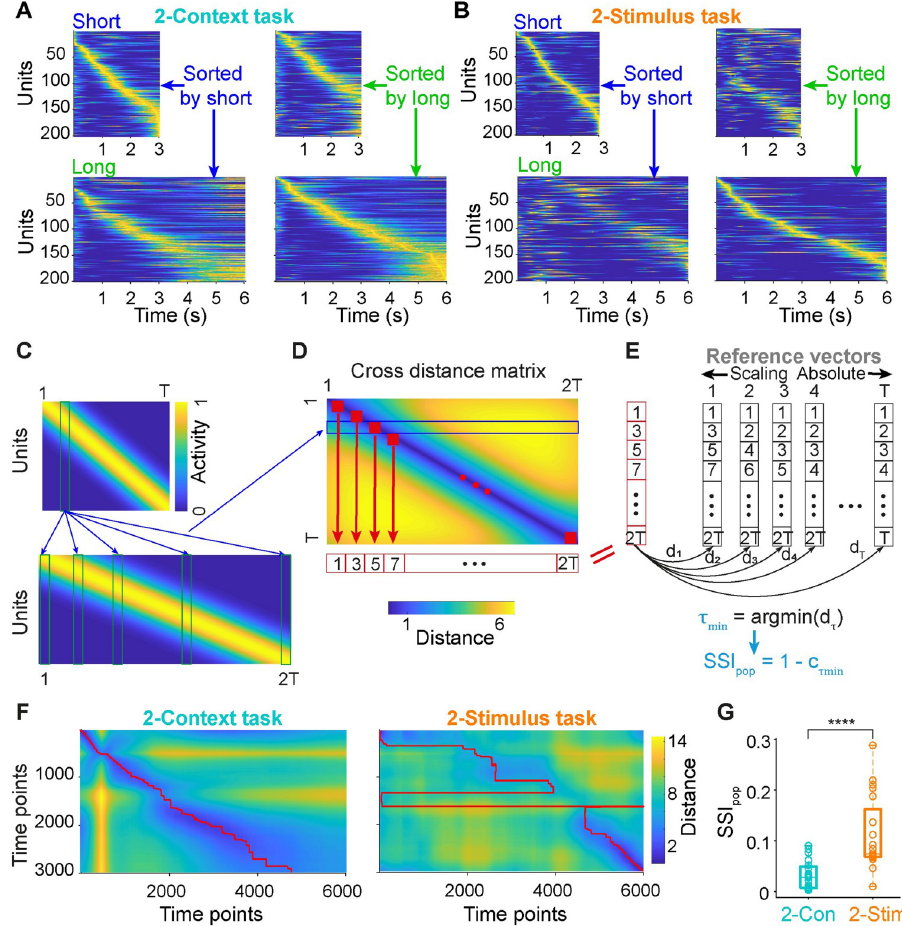
Fig 4. Distinct population dynamics in RNNs trained on the 2-Context and 2-Stimulus task. ( A ) Population activity for short (top) and long (bottom) intervals sorted according to the peak activity latency during short (left) and long (right) intervals for RNNs trained on the 2-Context task. ( B ) Same as A for the 2-Stimulus task. ( C ), ( D ), ( E ) Schematic of the calculation of the stimulus-specific index (SSI pop ). A prototypical neural sequence that undergoes pure temporal scaling from the short (top) to long (bottom) intervals is used as an example ( C ). The vectors of the pairwise time points from the short and long dynamics are used to calculate all pairwise Euclidean distances, and these pairwise distances comprise the cross-distance matrix ( D ), in which a row (e.g., blue rectangle) represents the distances between one column vector of short dynamics and all column vectors during the long dynamics. The minimal index vector (red vectors in ( D ) and ( E )) represents the indices along the x-axis that corresponds to the minimum distances for each row of the cross-distance matrix (red squares). A series of reference vectors that vary from pure scaling to pure absolute timing (black vectors) are compared to the minimal index vector, and a value τ min is defined as the τ at which the pairwise distance reaches the minimum. Finally, the correlation coefficient between the minimal index vector and the absolute-scaling reference vector at τ min is used to calculate SSI pop . ( F ) Cross distance matrices for an example simulation of the 2-Context (left) and 2-Stimulus tasks (right). Red lines denote the indices of the minimum values for each row. ( G ) SSI pop for RNNs trained on the 2-Stimulus task is significantly higher than that for 2-Context task ( n = 20 simulations for each, two-sided Wilcoxon rank-sum test P < 0.0001). Boxplot: central lines, median; bottom and top edges, lower and upper quartiles; bottom and top whiskers: